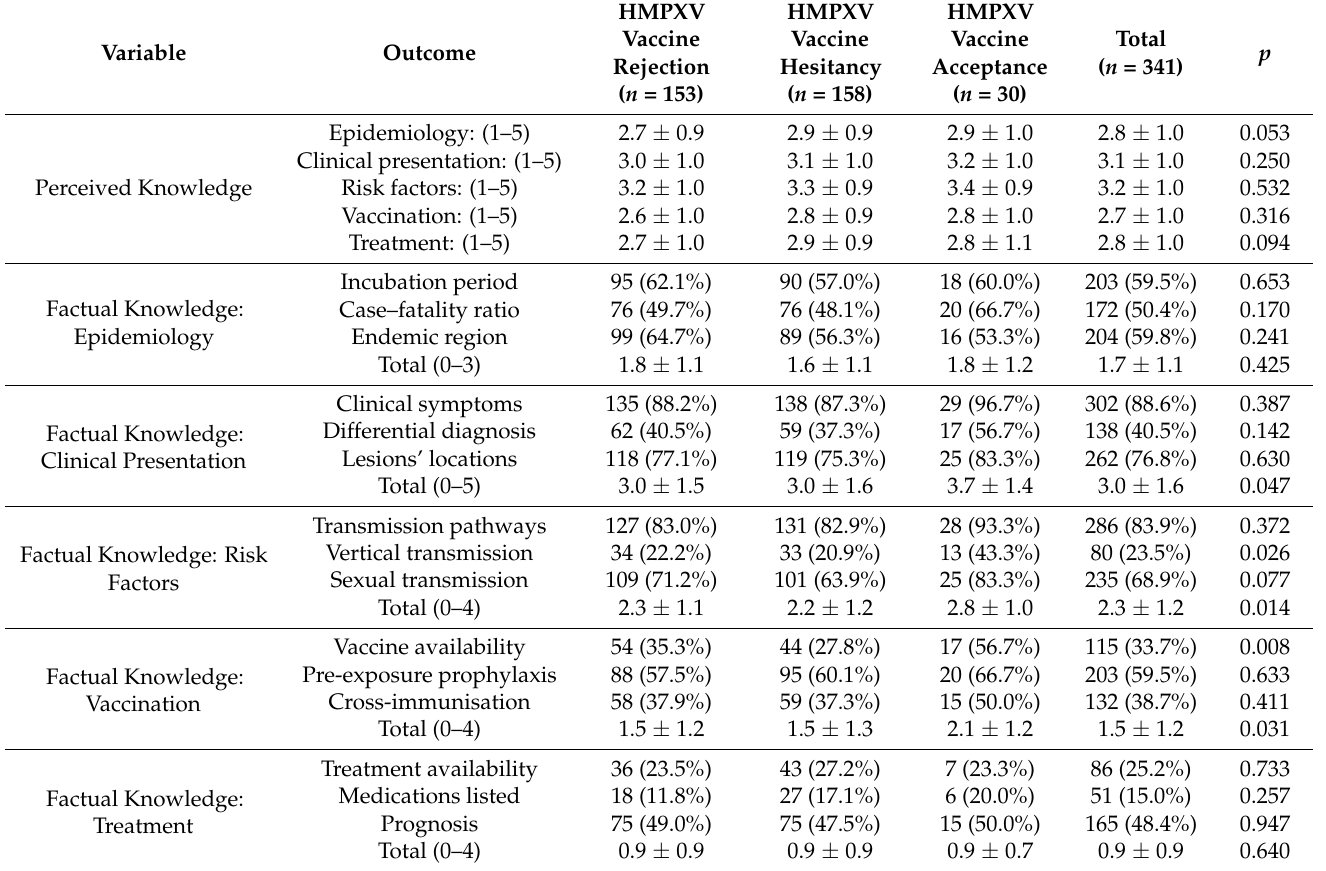
Table 4. Knowledge of Czech HCWs responding to the HMPXV survey, September 2022 ( n =